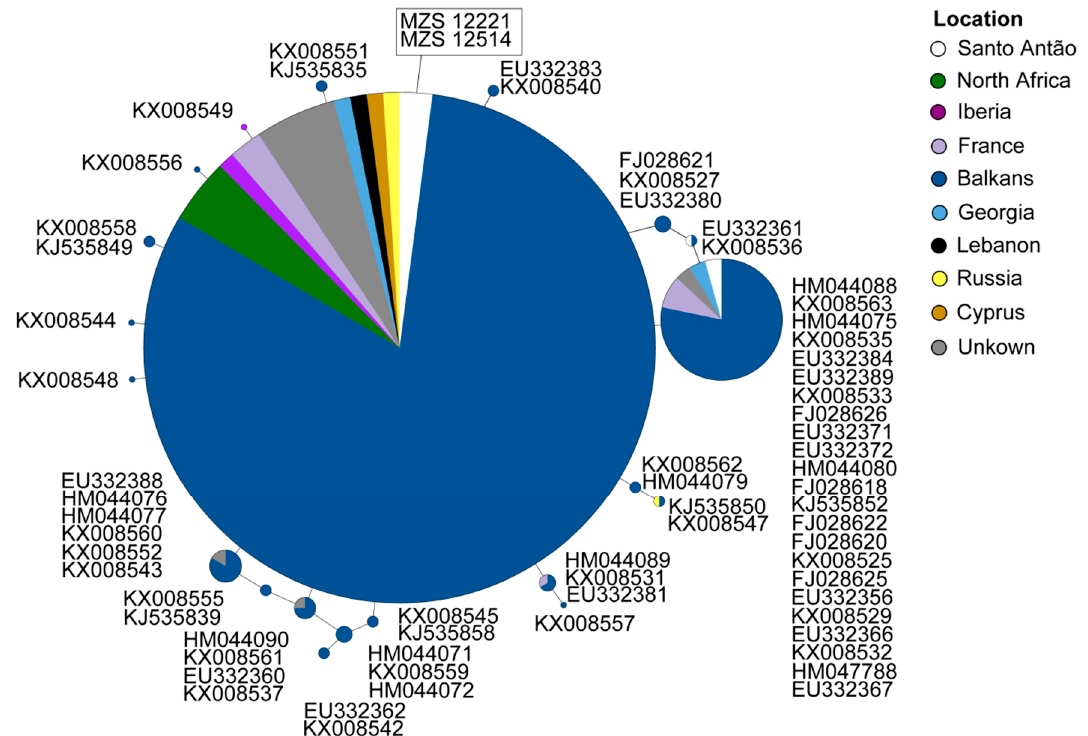
Figure 6. Parsimony network corresponding to the cyt b mtDNA sequences in Miniopterus schreibersii . Lines represent mutational steps, circles indicate haplotypes, and dots show missing haplotypes. The size of the circle is proportional to the number of individuals, and di ff erent colors correspond to di ff erent locations. The only samples from Cabo Verde are within a rectangle and correspond to the main central haplotype. For further details on the samples, see Figure 1, Table S1 and S3.